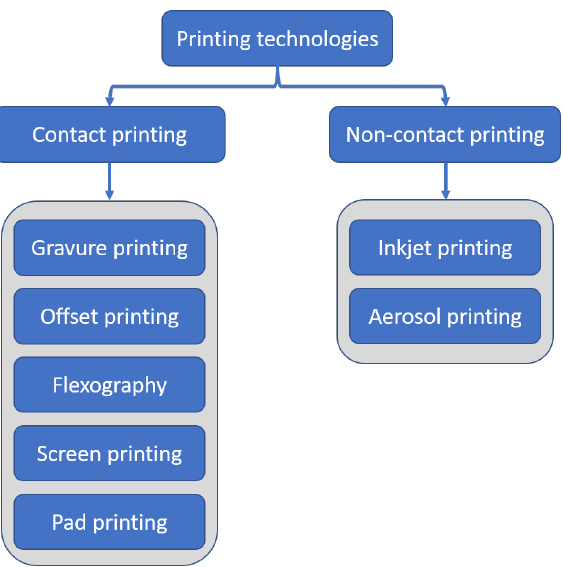
Figure 11. Classification of printing technologies.